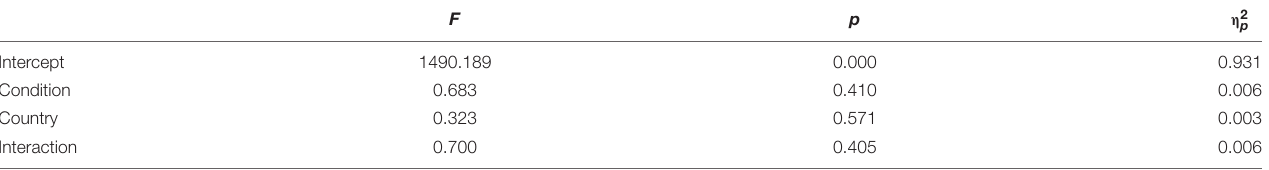
TABLE A1 | Country – condition interaction.